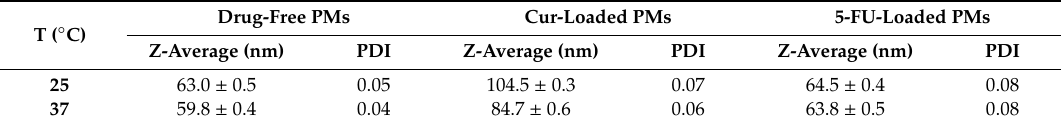
Figure 1. Volume size distributions for drug-free polymeric micelles (PMs; squares), Cur-loaded PMs (circles), and 5-FU-loaded PMs (diamonds) in PBS (pH = 7.4) at a concentration of 0.1 wt % and 37 ◦ C. Table 1. Z-average and polydispersity index (PDI) values of free and drug-loaded micellar systems based on the pH-sensitive P2VP 90 -b-PEO 394 block copolymer at a concentration of 0.1 wt% in PBS (pH = 7.4) and two temperature values, 25 and 37 ◦ C,